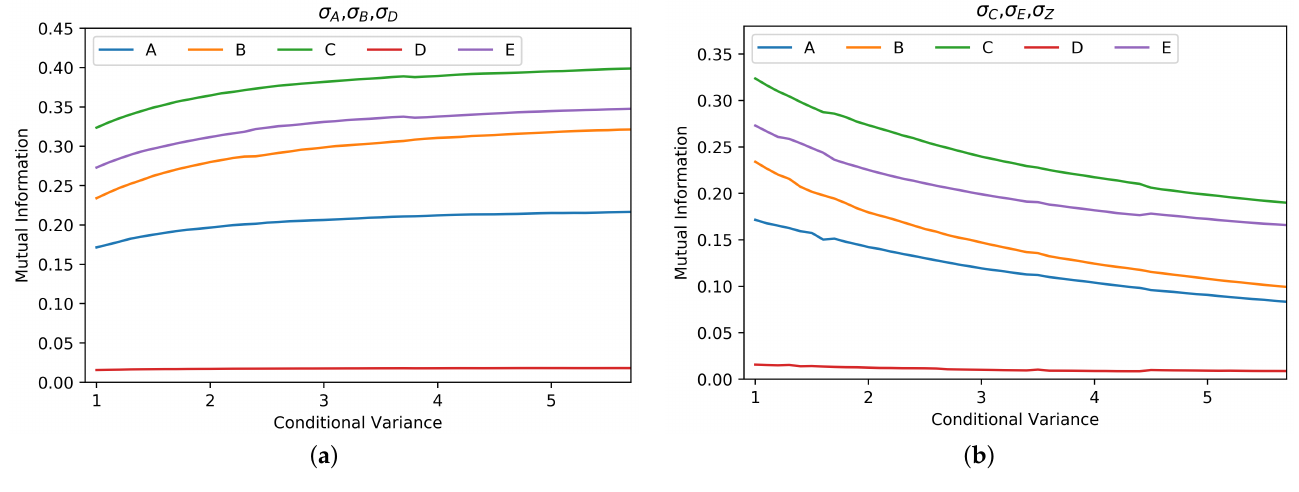
Figure 7. Mutual information between node Z and each other node, varying conditional variances. ( a ) M.I. as function of variances σ A , σ B , σ D ; edge weight equal to 0.1. ( b ) M.I. as function of variances σ C , σ E , σ Z ; edge weight equal to